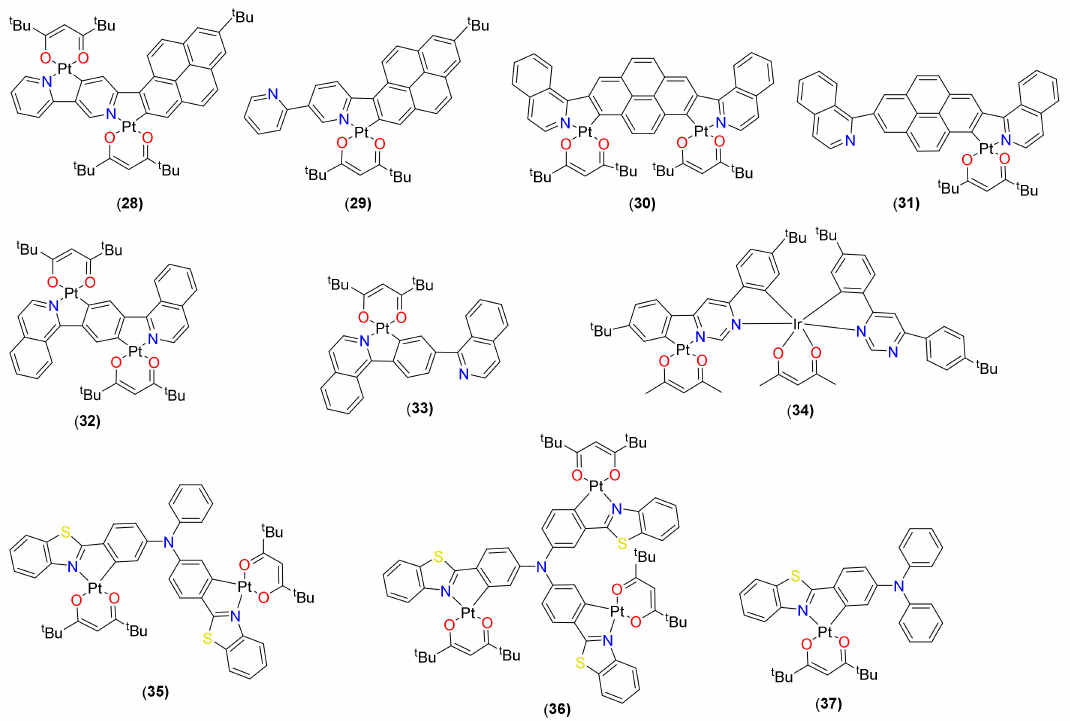
Figure 8. Mono-, di- and multinuclear Pt(II) complexes with excellent PL and OLED